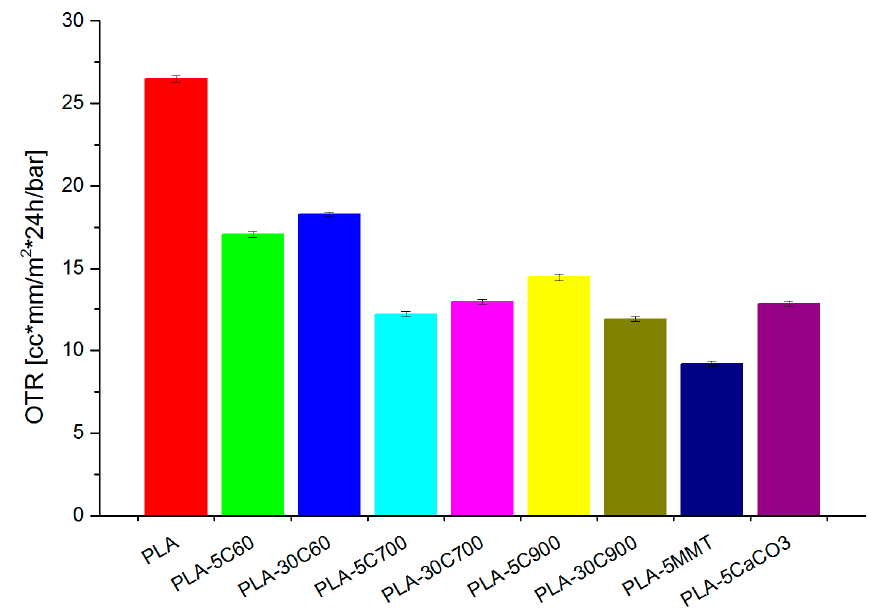
Figure 15. Oxygen permeability measured for investigated samples.